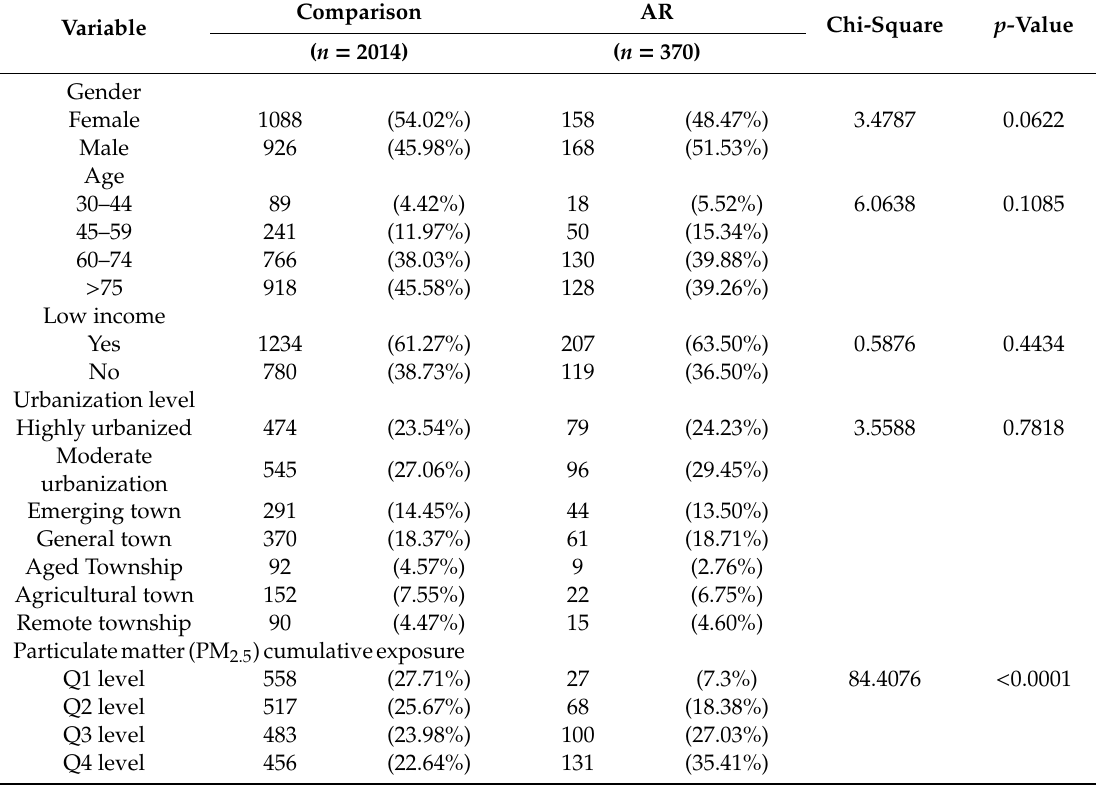
Table 1. Demographics of individuals with allergenic rhinitis and aged 30 years and above from